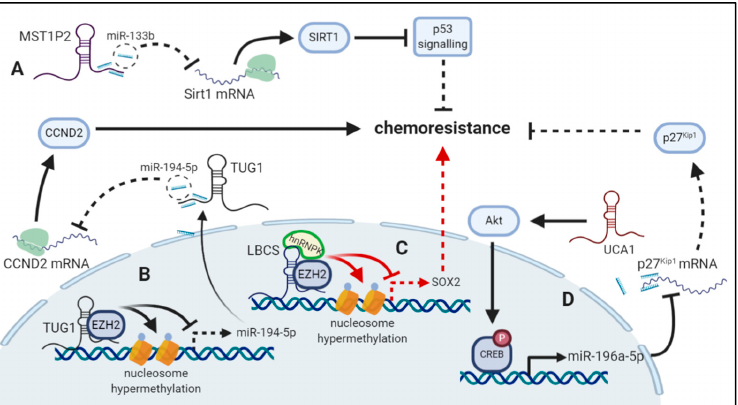
Figure 2. Examples of long non-coding RNAs (lncRNAs) and mechanisms of drug resistance in bladder cancer (BC). ( A ) lncRNA macrophage stimulating 1 pseudogene 2 (MST1P) sponges miR-133b